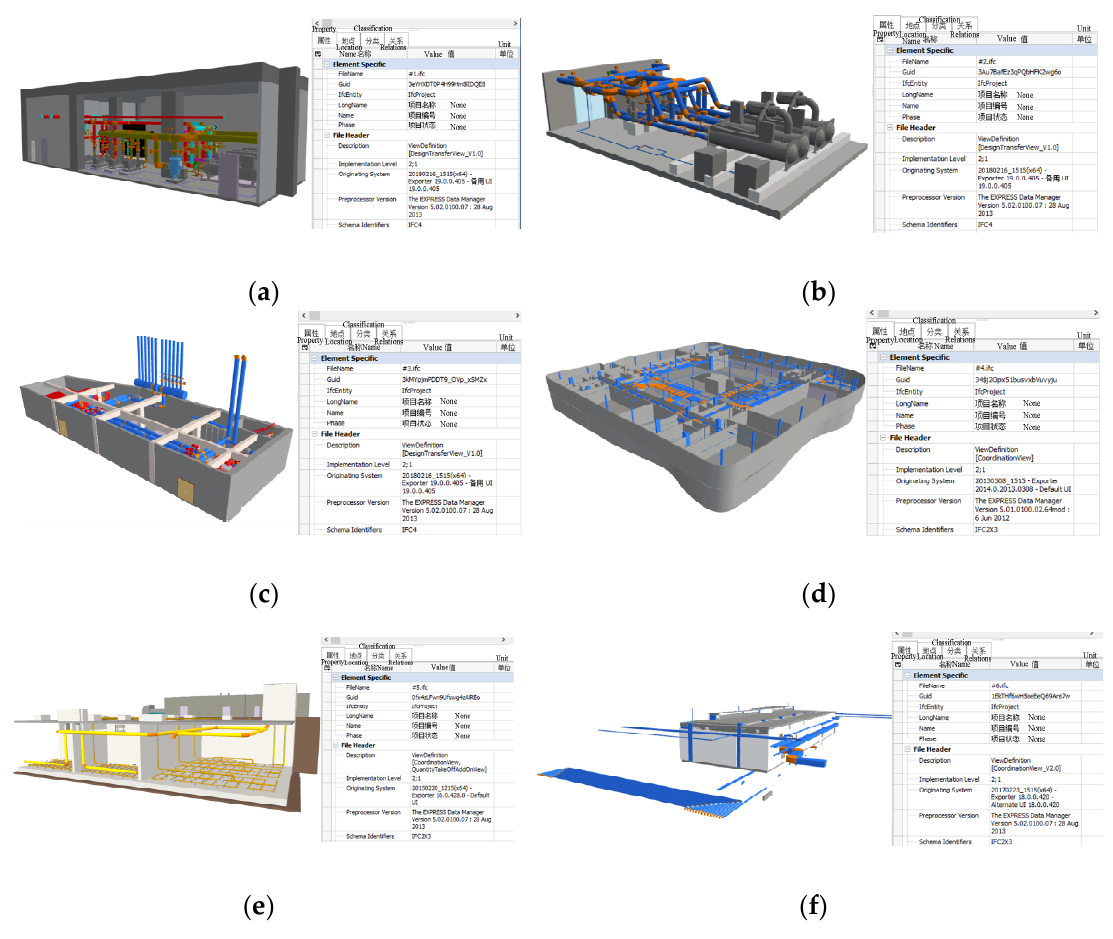
Figure 16. Three-dimensional shapes of six BIM models: ( a ) #1 an electronical room; ( b ) #2 a water pump room; ( c ) #3 an air-conditioning room; ( d ) #4 a floor pipeline system; ( e ) #5 a sewage treatment room; ( f ) #6 an electronical room.